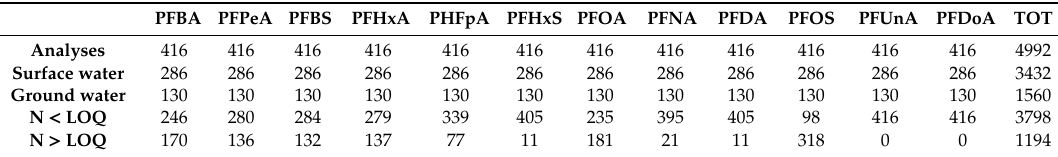
Table 6. Perfluorinated analyses in surface and ground water